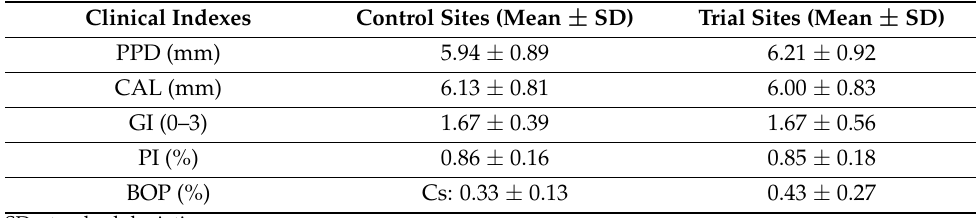
Table 2. Baseline characteristics of patients.